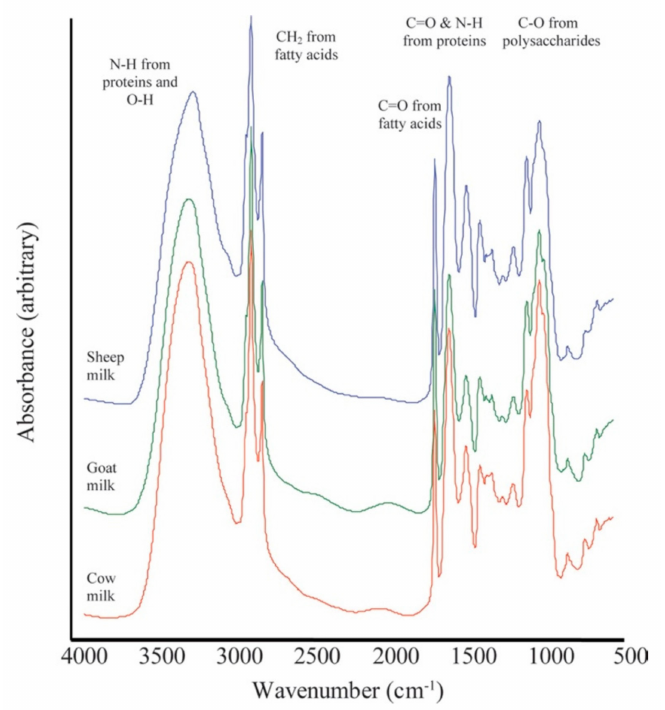
Figure 3. Fourier transform infrared spectra for pure cow, goat, and sheep milk. These spectra are offset to allow visualization of any difference. Reprinted from [72] with permission from